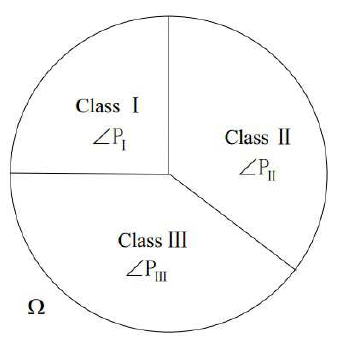
Figure 2. Schematic diagram of the preference phenomenon classification and the preference angle.